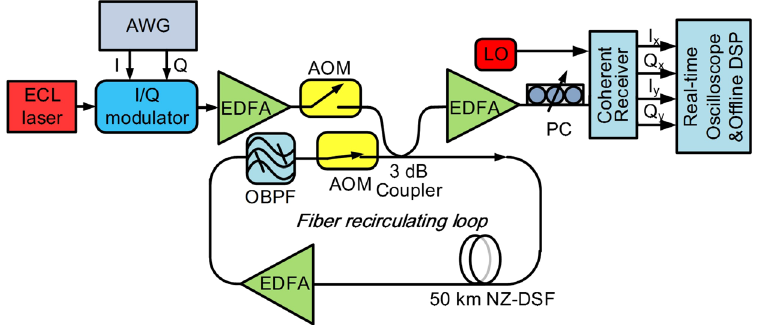
Figure 1. Experimental setup. ECL: external cavity laser; AWG: arbitrary waveform generator; AOM: acousto- optic modulator; EDFA: erbium doped fiber amplifier; NZ-DSF: non zero dispersion shifted fiber; OBPF: Optical band pass filter; LO: local oscillator; PC: polarization